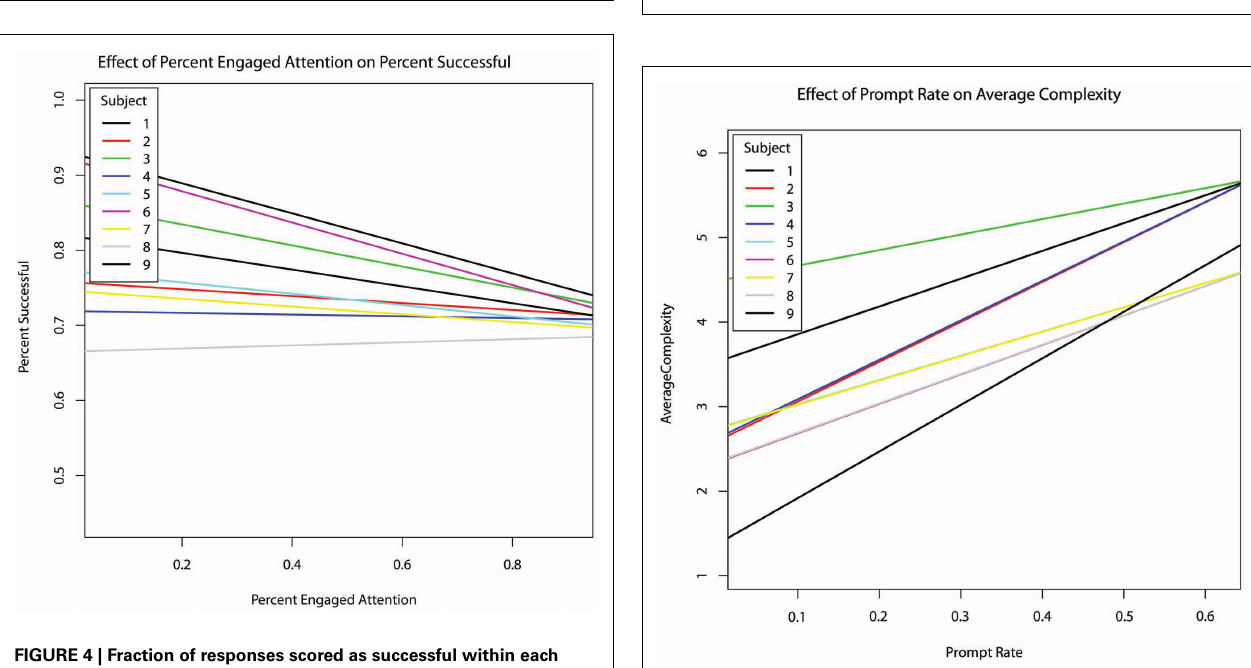
The rate at which the therapist provided proximal prompt- ing trended toward a negative relationship with success- ful responding ( b = − 0.7773, p = 0.1034). The percentage of